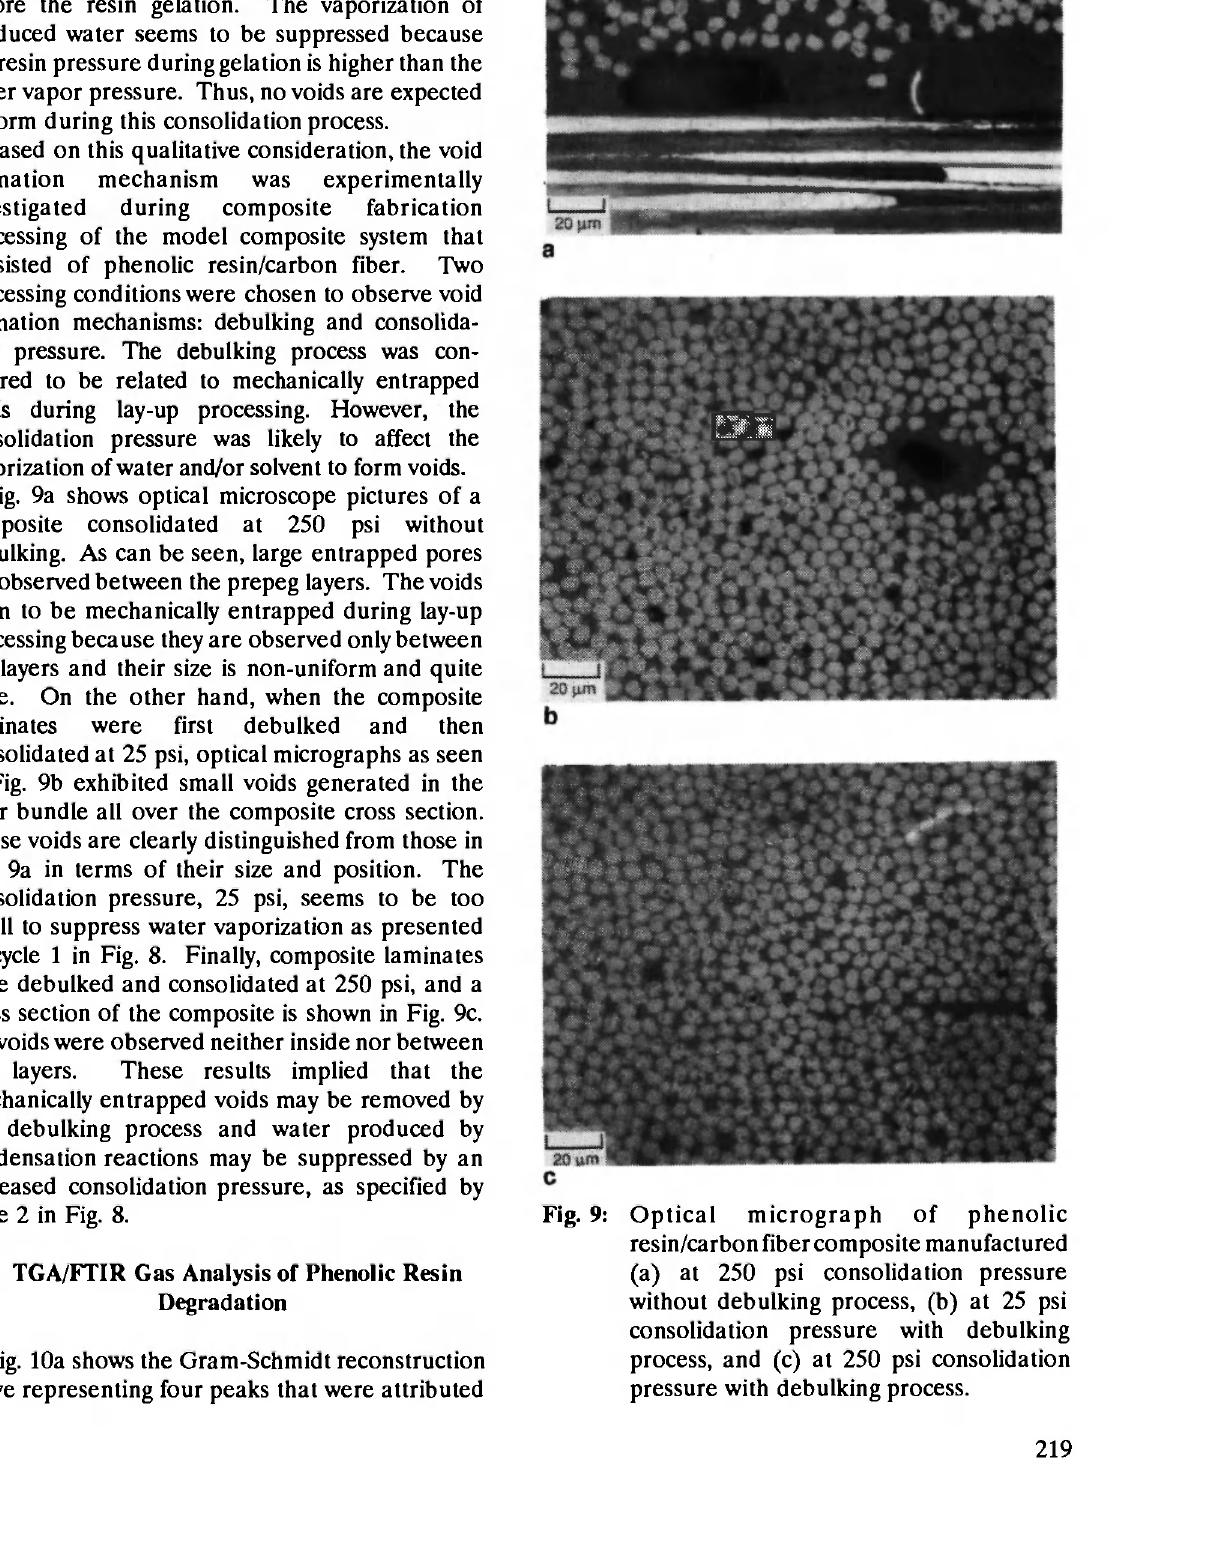
figure, cycle 1 crosses the water boiling curve possibly during gelation of the resin.